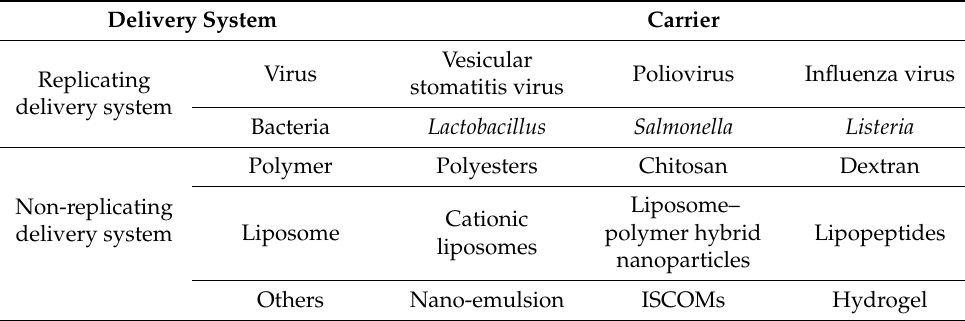
Figure 3. Different types of vaccine formulations for nasal delivery. Table 3. Various carriers of different systems for nasal vaccine